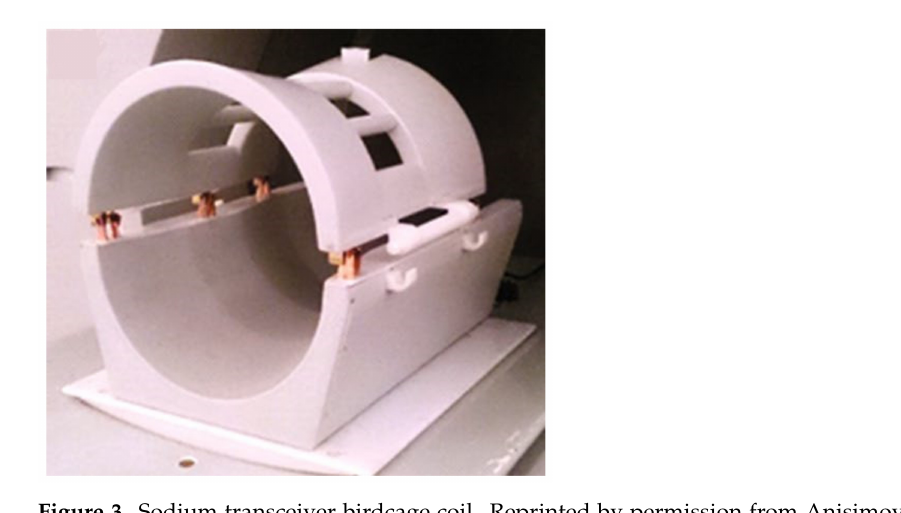
Figure 3. Sodium transceiver birdcage coil. Reprinted by permission from Anisimov et al., App Magn Reson 2019 [23].